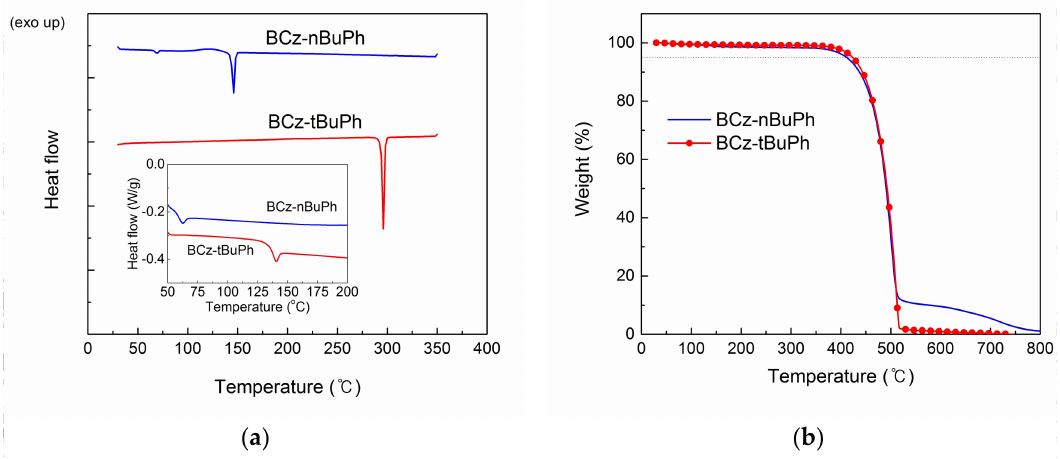
Figure 1. DSC curves on the first heating process ( a ) and the second heating process (inset) and TGA curves ( b ) of BCz-nBuPh and BCz-tBuPh .